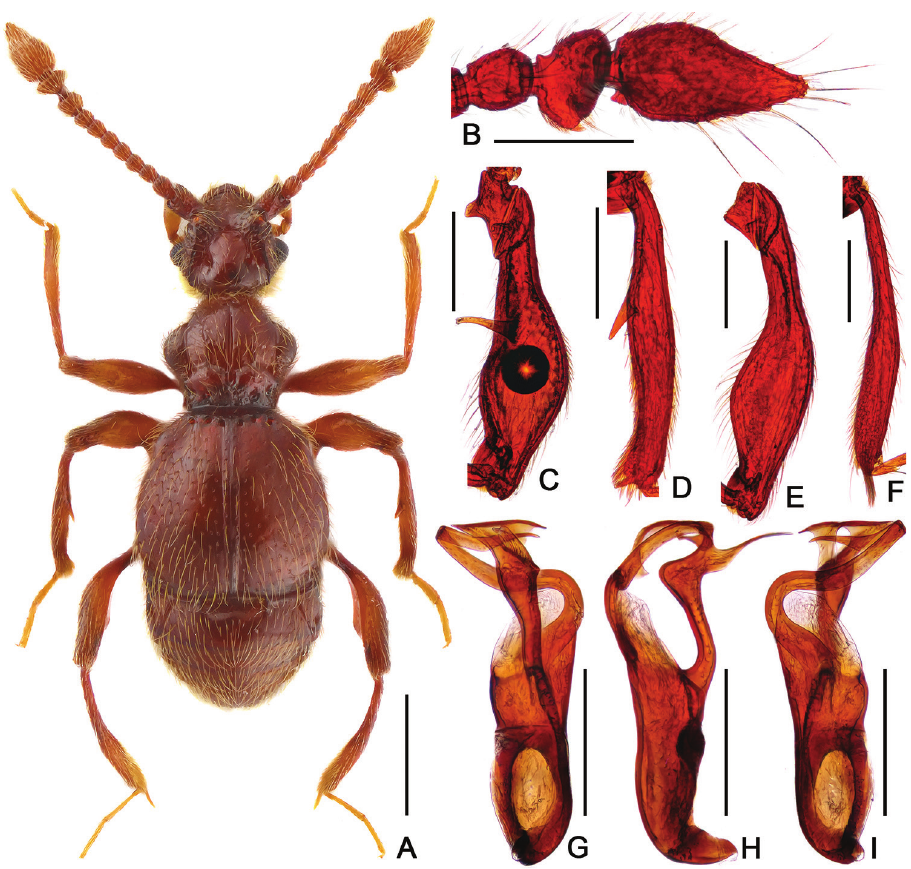
Figure 11. Diagnostic features of Batrisodes zhouchaoi , male. A Dorsal habitus B Antennal club C Mes- otrochanter and mesofemur D Mesotibia E Metatrochanter and metafemur F Metatibia G–I Aedeagus, in ventral ( G ), lateral ( H ), and dorsal ( I ) views. Scale bars: 0.5 mm ( A ); 0.2 mm ( B–I